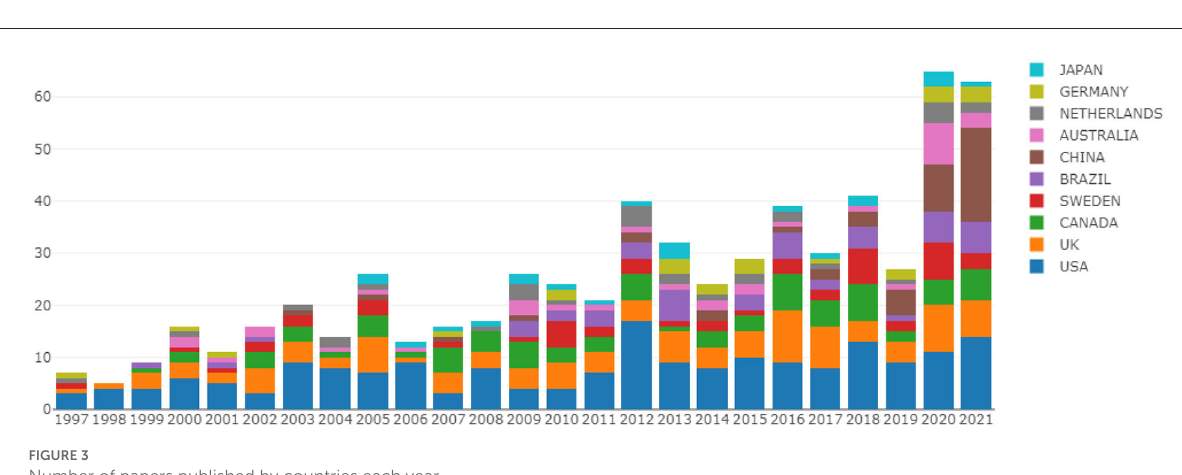
FIGURE3 Number of papers published by countries each